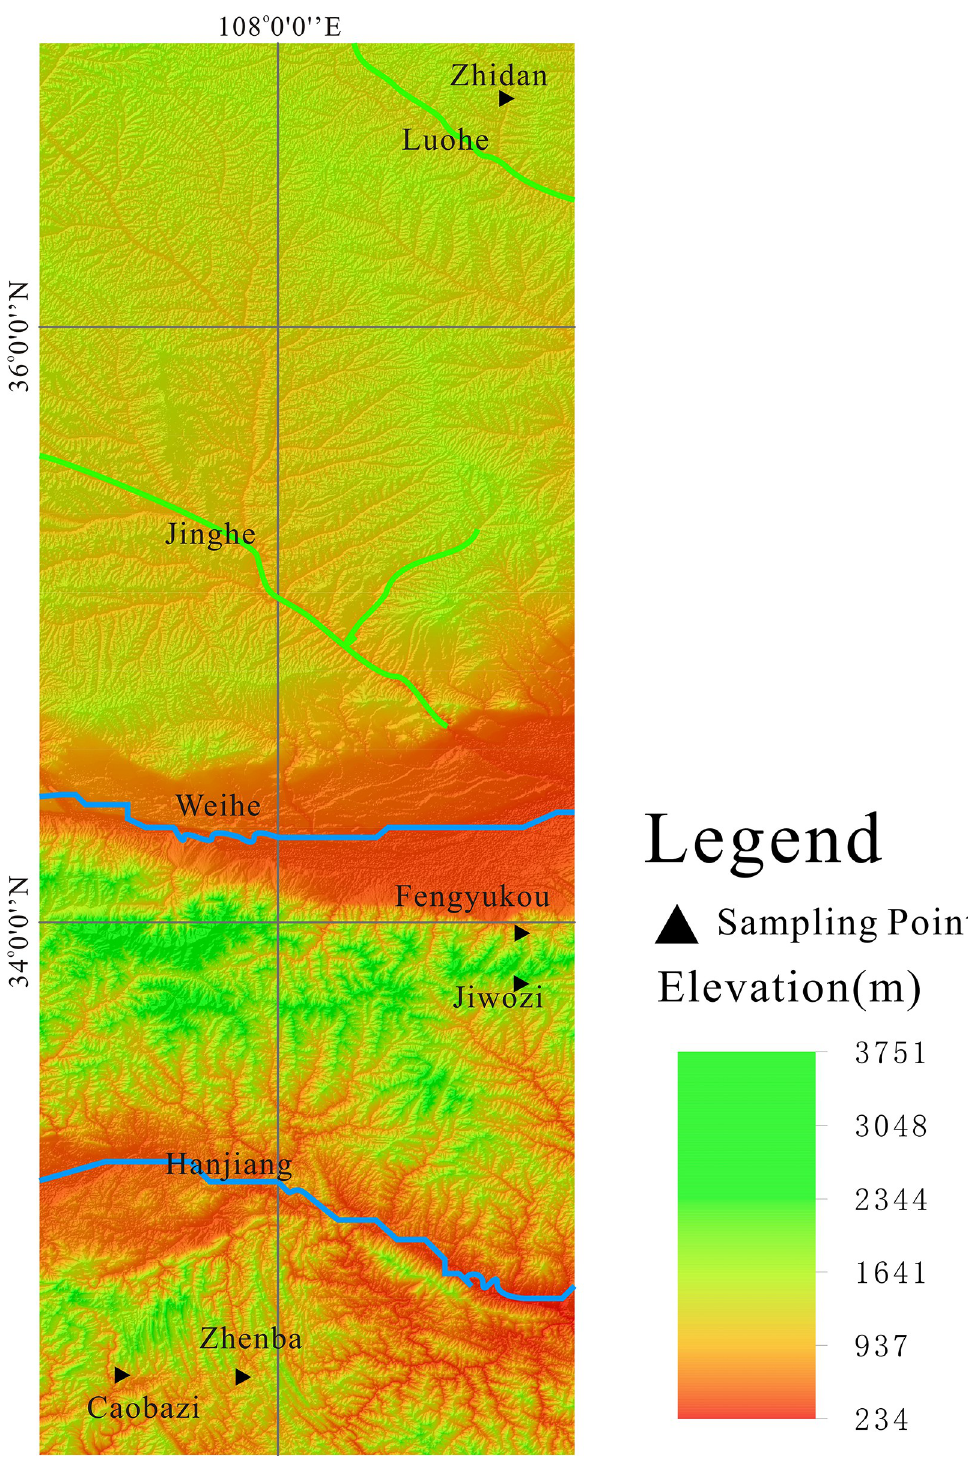
Fig 1. Map of the sampling sites. (http://landsat.visibleearth.nasa.gov/)[44].